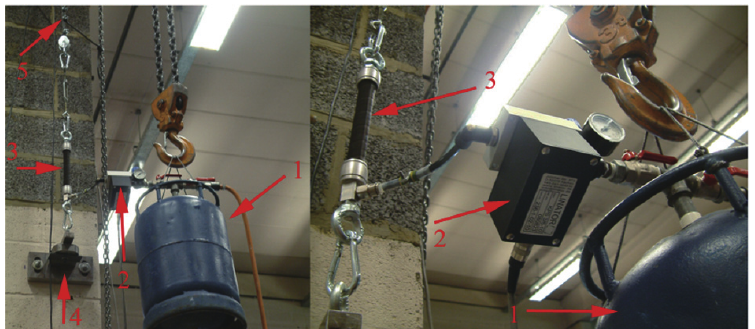
Fig. 5. Connection of the DMSP20 to the wall and setup of the proportional valve and pressure vessel. 1: Pressure vessel, 2: Proportional valve, 3: DMSP20, 4: Attachment to the wall, 5: Connection with the kevlar cable. The data acquisition is performed using a SLDV (Polytec PSV400). A grid of 8 by 9 measurement points is selected in between two consecutive joists to ensure that the movement of only the ceiling panels is registered. The acquisition mode is set to FFT with a complex averaging of fi ve periods. The bandwidth is set between 0 and 20 Hz since the spectral composition of the excitation signal is limited to 10 Hz. The sampling frequency and measurement time per scanned point are 640 Hz and 25.6 s respectively, resulting in 6400 FFT lines and a spectral resolution of 39